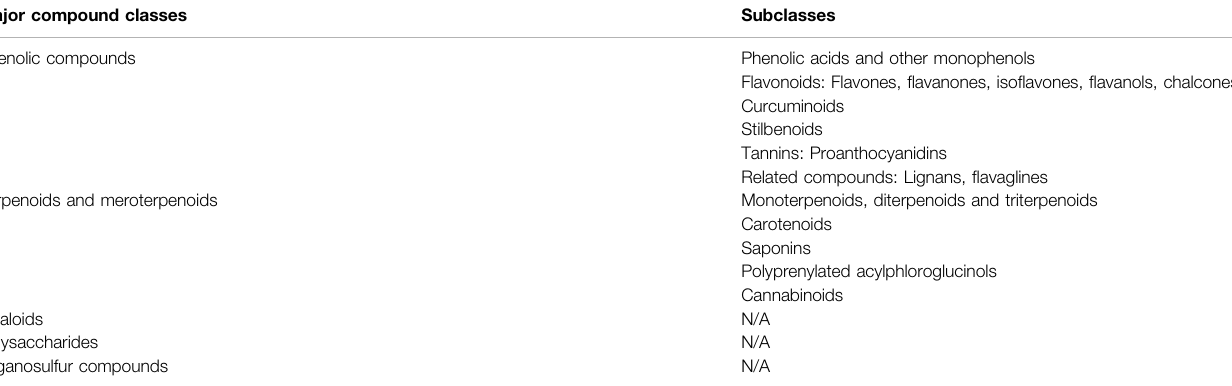
TABLE 1 | Major classes and subclasses of organic chemicals, and their speci fi c natural compounds, whose potential role in cancer therapy has been summarized in this review. N/A, not